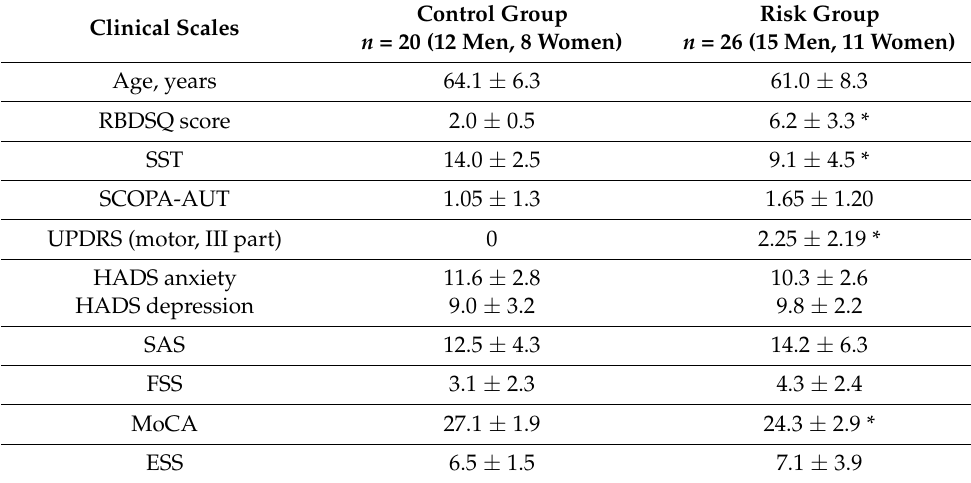
Table 1. Clinical characteristics of the patients included in the study. Clinical